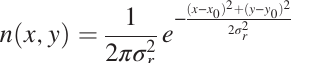
FIG. 4. Comparison of theory and numerical simulations of density (a) and velocity (b) modulation by ion moving with σ v with respect to uniform electron